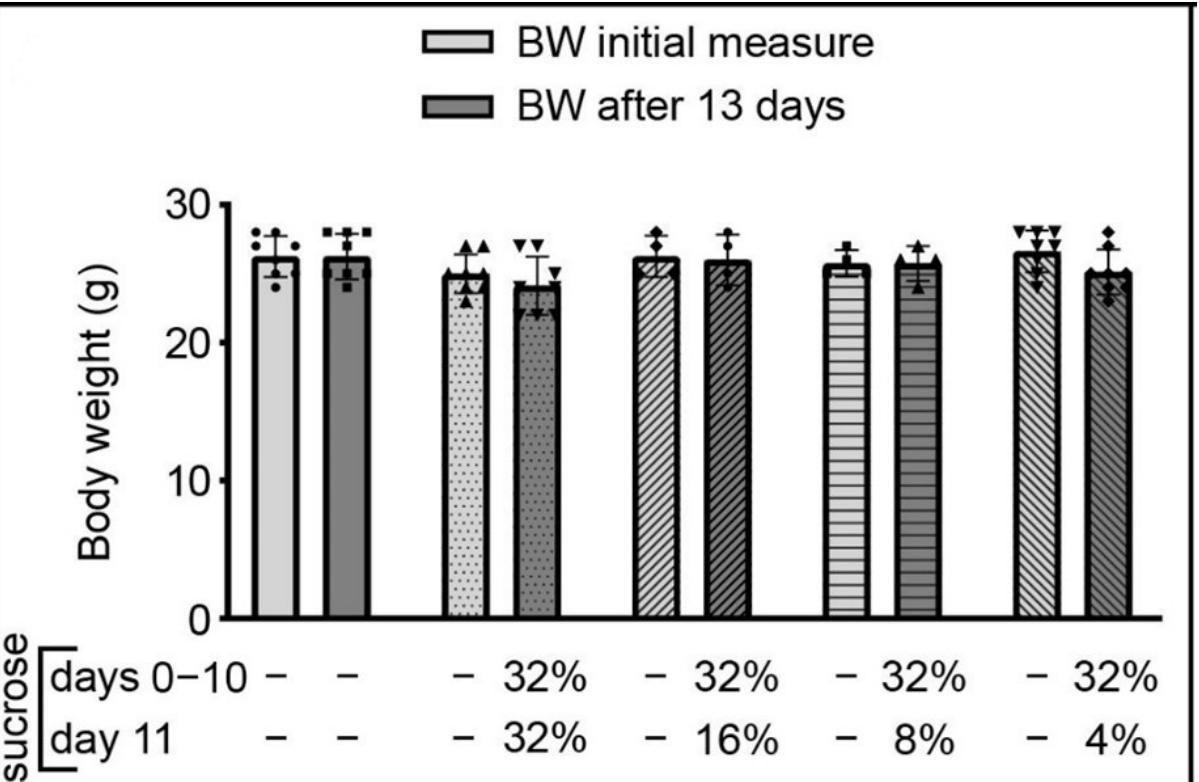
Figure 3. Changes in body weight of adult male C57BL/6J mice associated with ad libitum access to sucrose solution(s). The data are represented as mean ± SD, with individual data plots along col- umn bars (8 animals per group in all except in 32% → 16% and 32% → 8% downshifted groups which